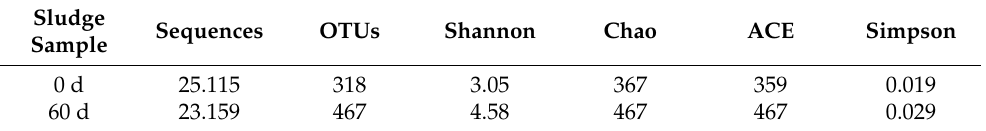
Table 2. Statistical results of the alpha diversity index in different sludge samples.